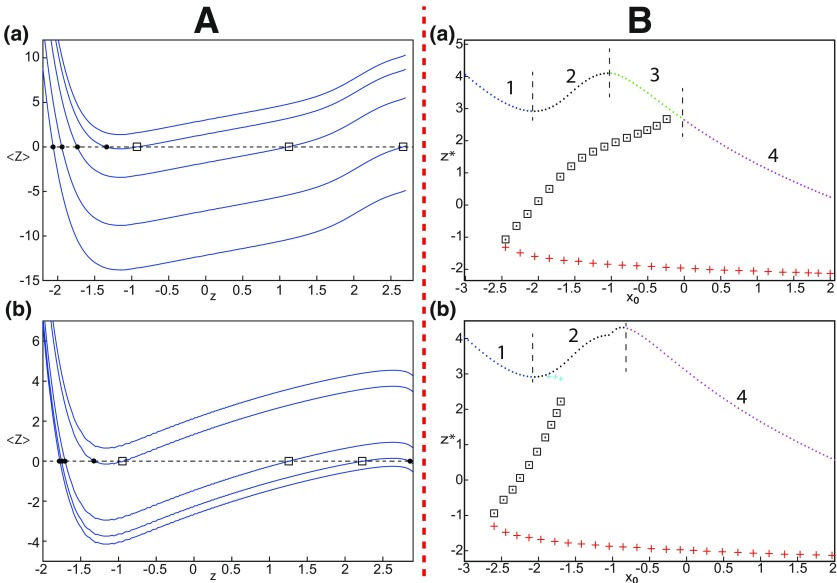
Periodic orbits of subsystem 1. A, Finding periodic orbits with respect to z (constant). We plot the graph of the Equation 65 on its right-hand side for different values of x0 (from bottom to top; x0 = 1, −0.25, −1.6, −2.4, −2.8) for m  =  0 (a) and (x0 = −1.6, −1.7, −1.9, −2.6, −2.8) for m  =  2 (b). Stable and saddle periodic orbits are labeled as black circles and squares, respectively, which disappear as x0 decreases through a SNPO bifurcation. B, The fast-slow subsystem parameter space of periodic orbits and equilibrium points with respect to x0. a, m  =  0. b, m  =  2. Saddle periodic orbits, S, are labeled as black squares (with dot). Stable periodic orbits LC (bottom, red) and SLC1 (top, blue) are labeled as (+) markers. Equilibrium points are labeled as dots. Blue (segment 1), black (segment 2), green (segment 3), and purple (segment 4) dots correspond to stable nodes, saddles, stable foci and unstable foci, respectively.